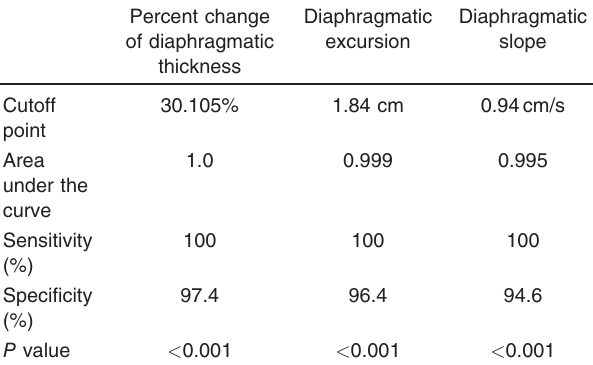
Table 6 Interobserver and intraobserver variability Table 7 The receiver operating characteristic curve of percent change of diaphragmatic